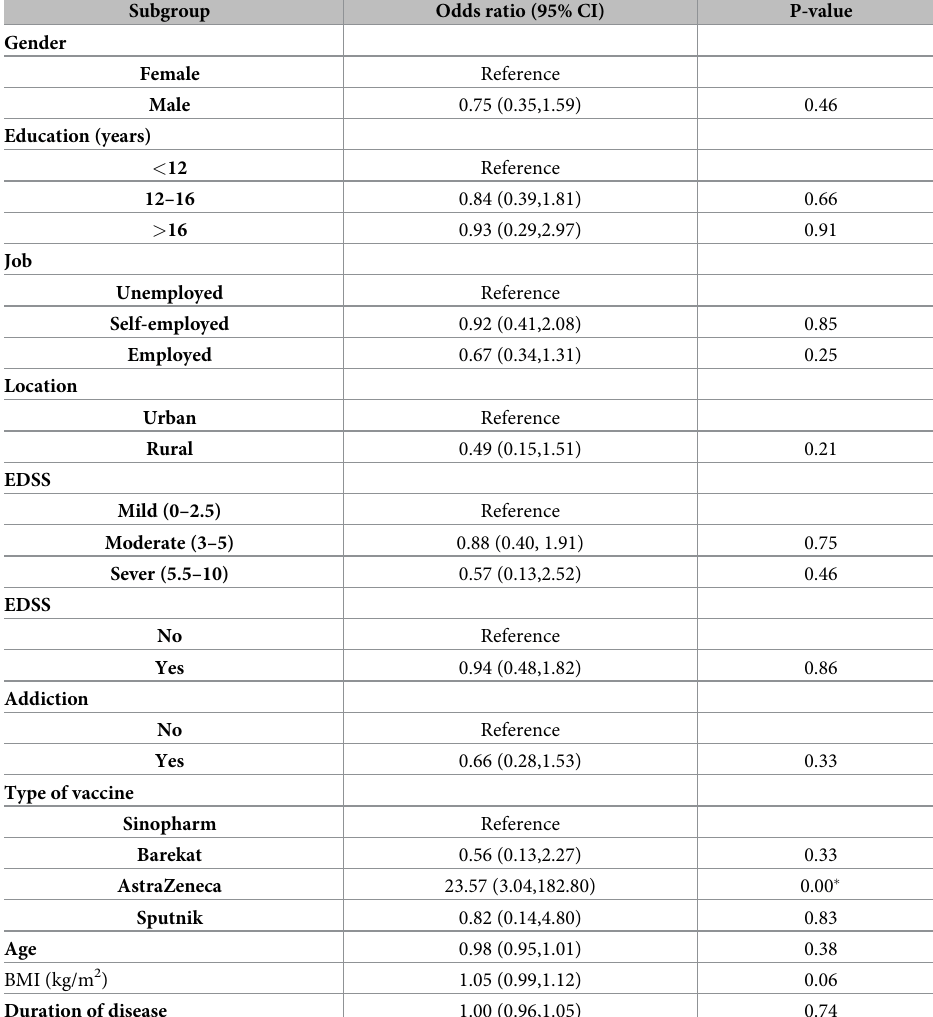
Table 4. Logistic regression analysis of factors associated with adverse effect of vaccination.